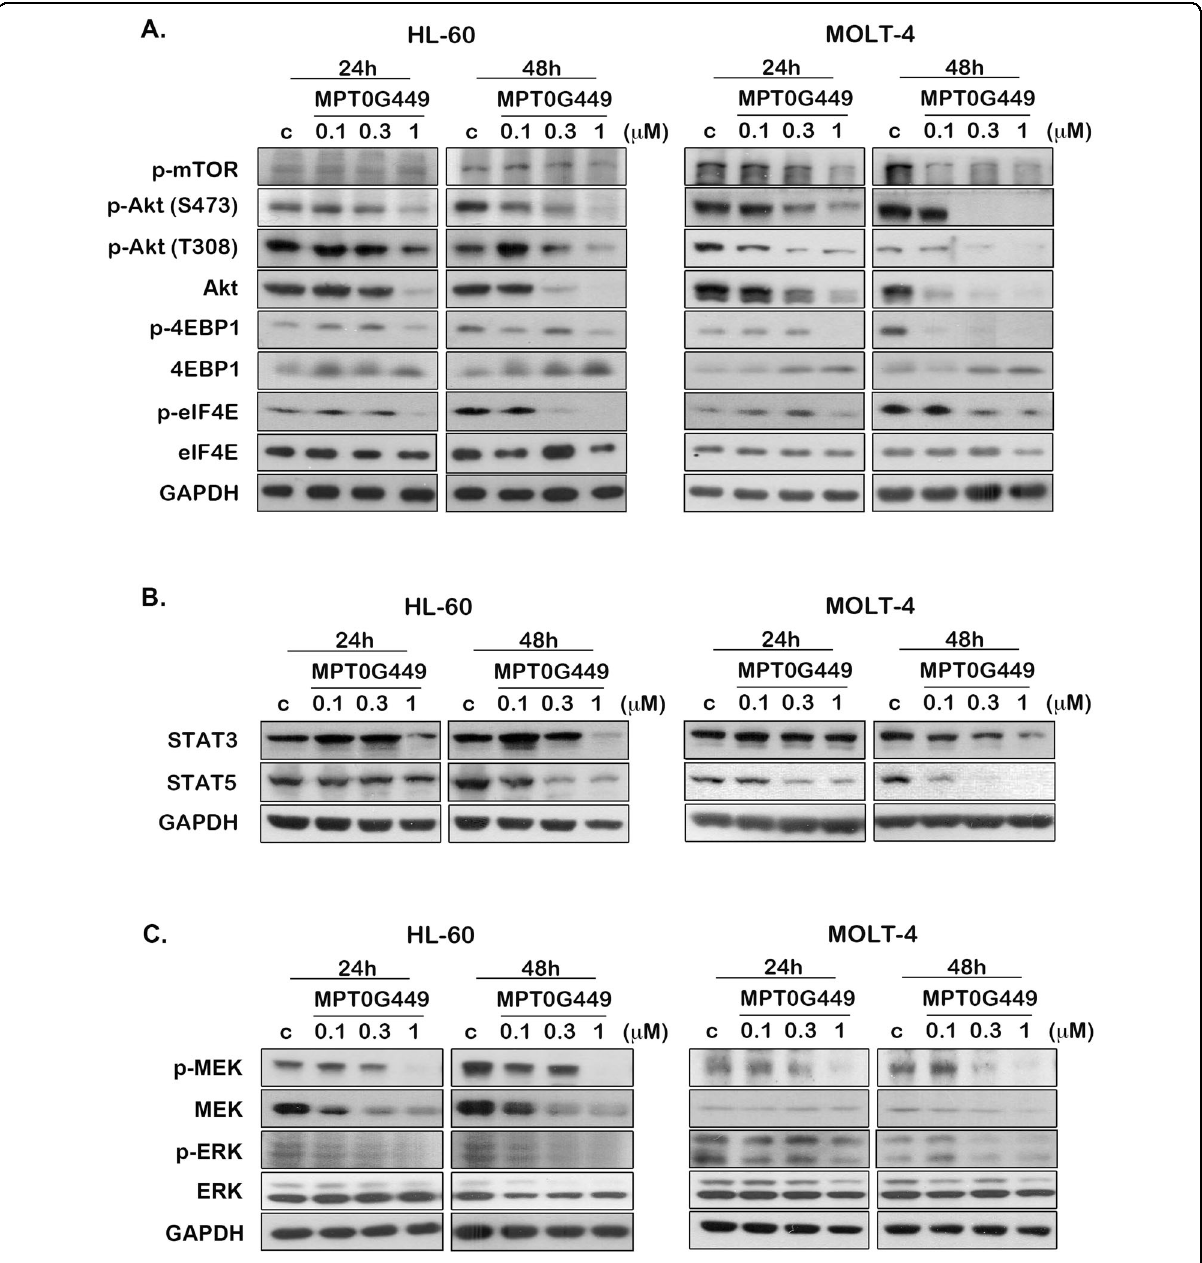
Fig. 5 The inhibitory effect of MPT0G449 on AKT/mTOR, STAT, and MEK/ERK signalings. HL-60 and MOLT-4 cells were incubated with MPT0G449 (0.1, 0.3, 1 μ M) for 24 or 48 h, then determined A AKT/mTOR signaling proteins, p-mTOR, p-Akt (S473), p-Akt (T308), Akt, p-4EBP1, 4EBP1, p- eIF4E and eIF4E, expression. B The level of STAT signalings, STAT3 and STAT5, and C MEK cascade signalings, p-MEK, MEK, p-ERK, and ERK were determined after MPT0G449 treatment. The whole-cell lysates were examined by western blotting, and these results were repeated at least three independent